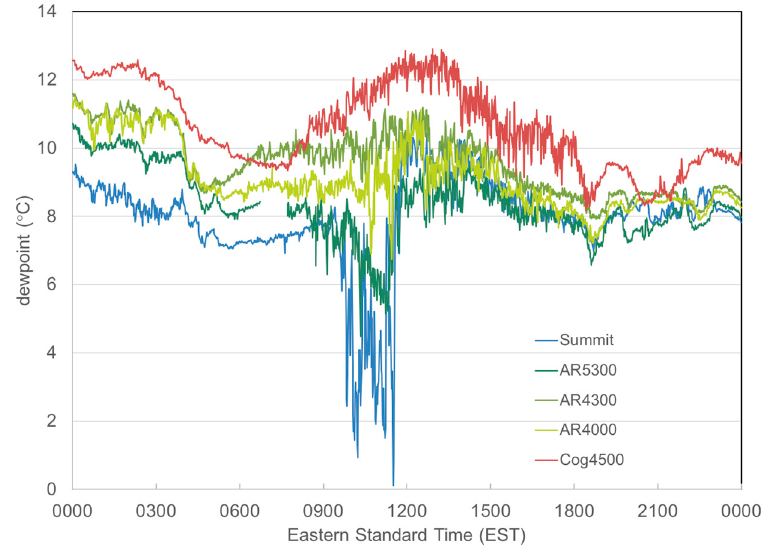
Figure 4. Time series of dewpoint (°C) at the summit, AR5300 AR4300, and AR4000, and Cog4500 mesonet stations on 19 August 2016.